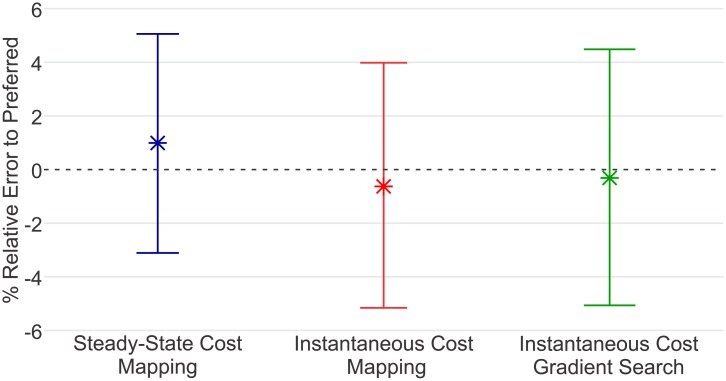
Accuracy of the Three Methods.Shown are means and standard deviations of the predicted energetic minima. We use the subjects’ preferred step frequency as ‘ground truth’ for comparison [15]. All three methods, on average, identify energetic minima near the subjects preferred cadence. The variance in the outcomes of the proposed Instantaneous Cost methods is only slightly higher than that of the established Steady-State Cost Mapping. There is no significant difference between the absolute error of the three methods.